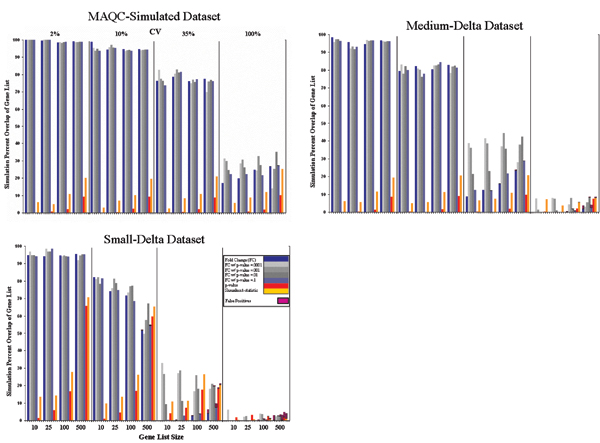
Gene selection and percentage of agreement in gene lists in simulated data sets. Illustrations of the effect of biological context, replicate CV distribution, gene list size, and gene selection rules/methods on the reproducibility of gene lists using simulated microarray data. In some sense, these three graphs represent some extremes as well as typical scenarios in differential expression assays. However, FC sorting with low P thresholds (0.001 or 0.0001; light and medium gray boxes) consistently performed better overall than the other rules, even when FC-ranking or P-ranking by itself did not perform as well.